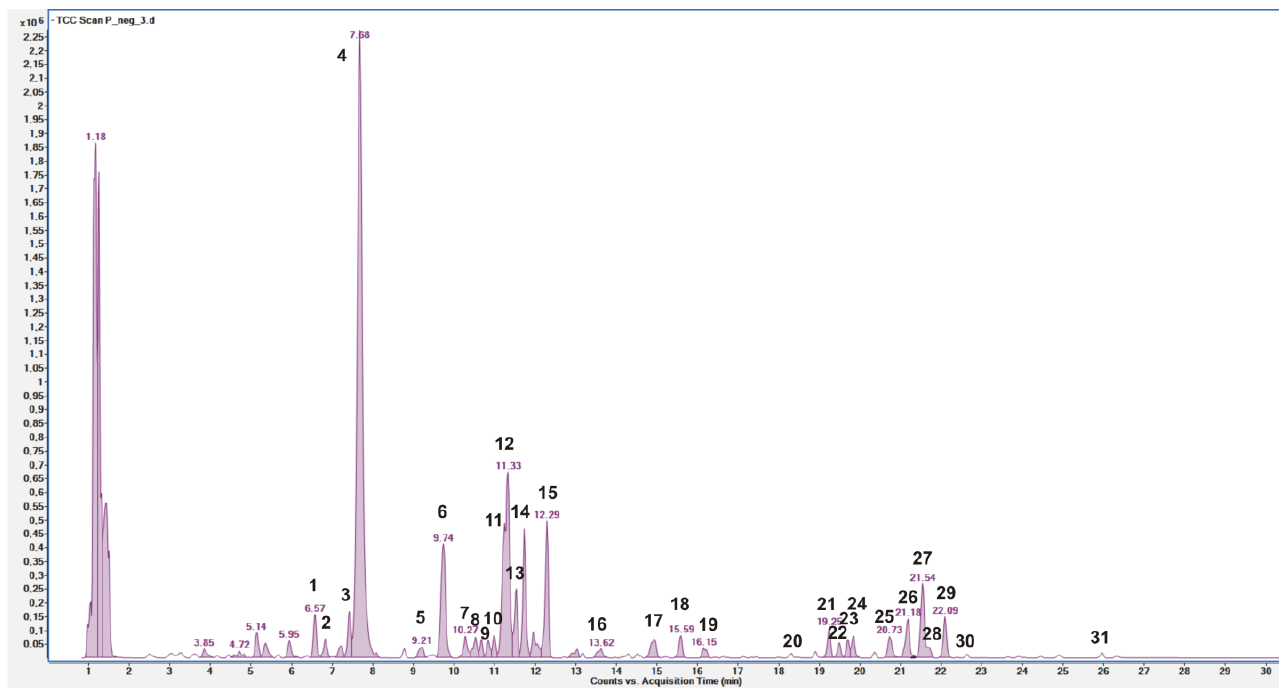
Figure 1. LC QTOF MS Total Compound Chromatogram of P. spinosa fruit extract acquired in negative ion mode. Peaks identification is given in Table 2. Table 2. Compounds identification by (HR) LC-ESI-QTOF MS/MS in P. spinosa fruit extract.